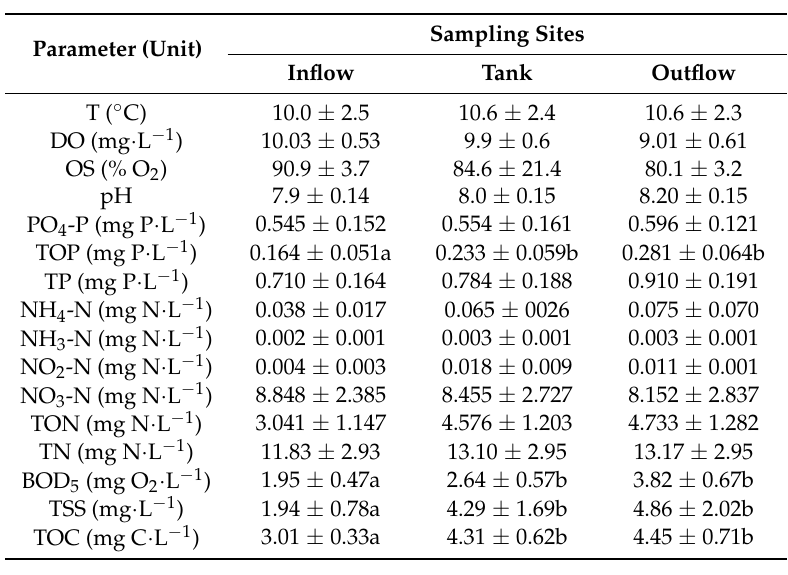
Table 3. Mean values and standard deviation ( ± SD) of the physicochemical parameters of water samples collected from the inflow to fish tanks, from fish tanks and from the outflow from tanks in RAS during farming of European grayling ( Thymallus thymallus L.) broodstock. Statistically significant differences between water samples collected from the inflow (N = 17), tank (N = 34) and outflow (N = 17) were assessed by the Tukey multiple comparison test (RM-ANOVA, p ≤ 0.05) and depicted by different letters: a—inflow and b—tank. Dissolved oxygen (DO), oxygen saturation (OS), 5-day biochemical oxygen demand (BOD 5 ), orthophosphates (PO 4 -P), total phosphorus (TP), NH 4 -N, NH 3 -N, NO 2 -N, NO 3 -N, total suspended solids (TSS), total organic carbon (TOC), total nitrogen (TN), total organic nitrogen (TON), and total organic phosphorus